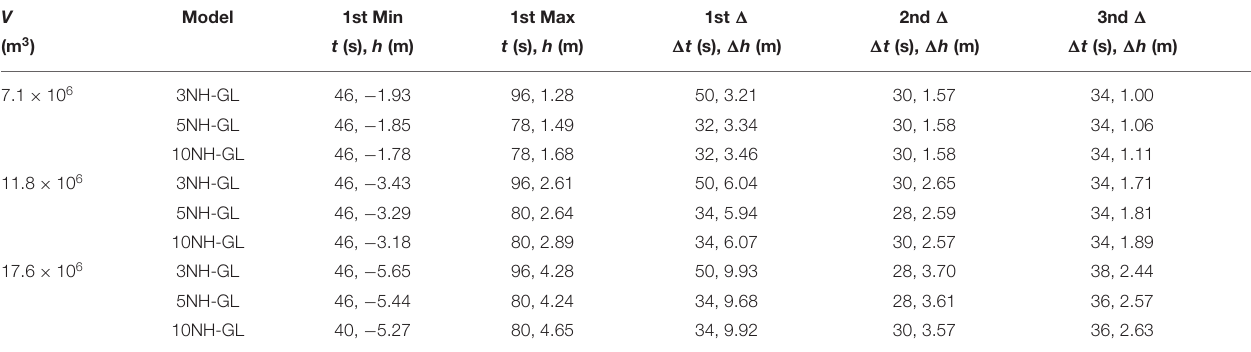
TABLE 6 | Wave minima and maxima with respect to the average sea level at gauge 1, characterized by the time after landslide release ( t ) and surface elevation ( h ). V